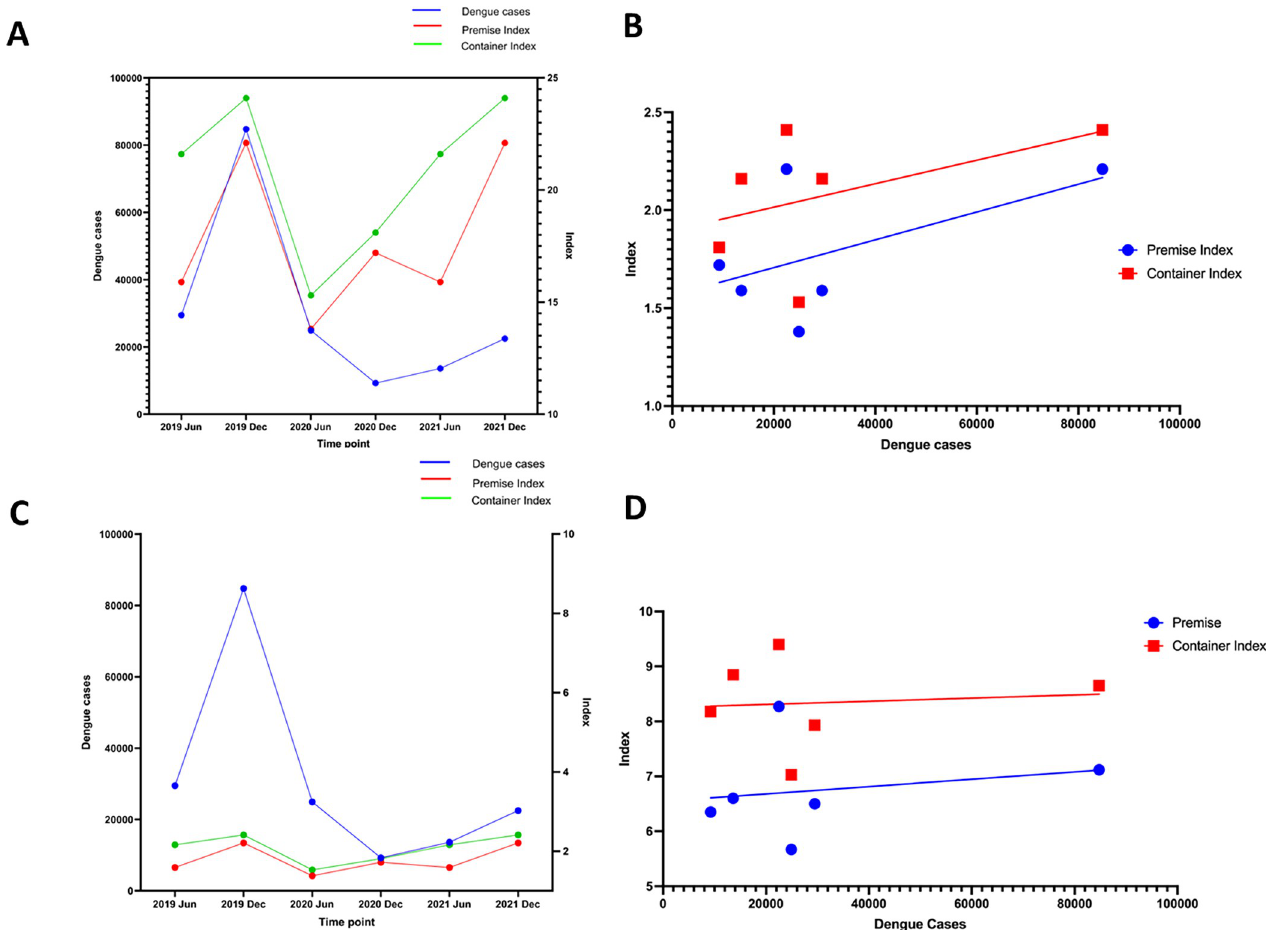
Fig 5. The relationship between the number of dengue cases with mosquito indices. Changes in the number of dengue cases with the Aedes aegypti and Aedes albopictus and container and premise indices data obtained from NDCU vector surveillance from January 2019 to December 2021 was plotted. The container and premise indices Aedes aegypti (A) and the correlation between the number of cases in vector indices Aedes aegypti (B) showed no correlation with the number of dengue cases with premise index (Spearman’s r = 0.8827, p = 0.93) and container indices (Spearman’s r = 0.3825, p = 0.4667). The relationship between the number of dengue cases with container and premise indices Aedes albopictus (C) and the correlation between the number of cases in vector indices Aedes albopictus (D) again showed no association seen with the number of dengue cases with premise index (Spearman’s r = 0.2, p = 0.7139) or with the container index (Spearman’s r = -0.2571, p = 0.6583).